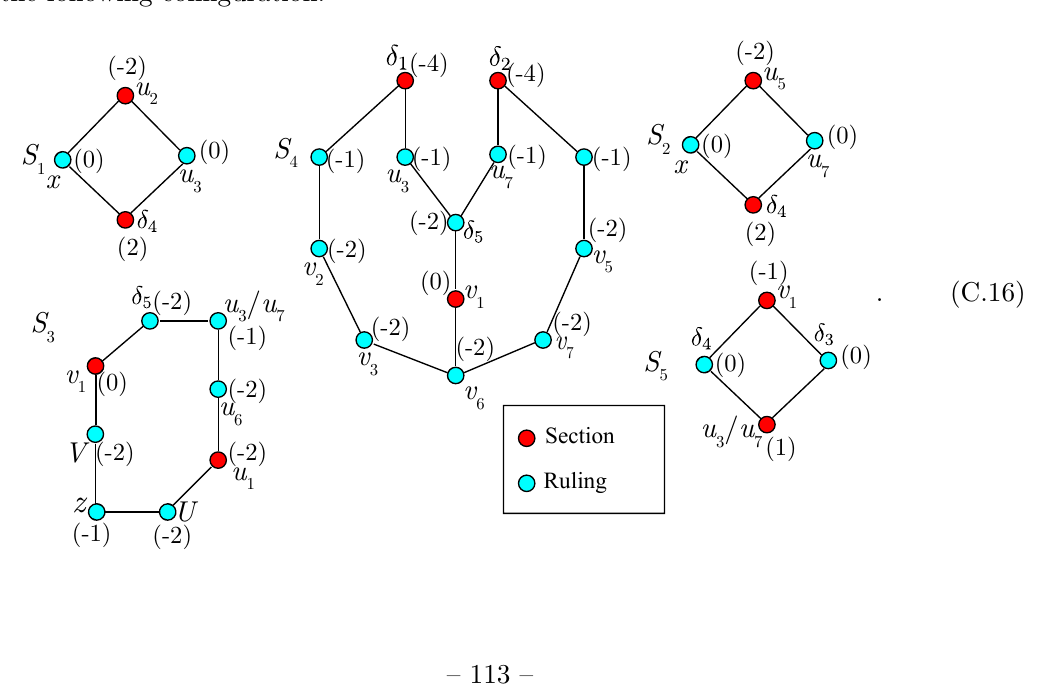
Figure 41. The con(cid:12)guration of curves on S i ( i = 1 ; : : : ; 5) in the geometry BU 1 number in the bracket denotes the self-intersection number of the curve. The letter denotes an intersection curve with the corresponding divisor. The \/" symbol means that the curves are in the same homology class. The assignment of section/ruling of each curve is marked by red/blue